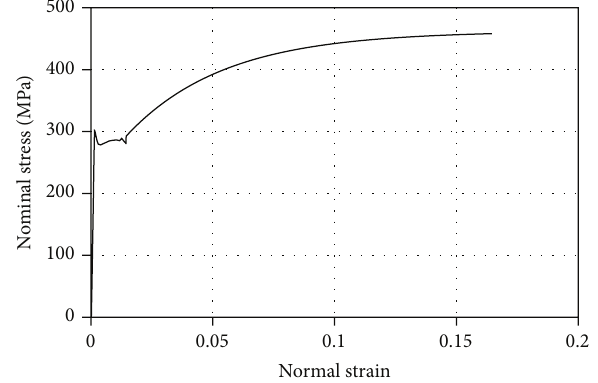
Figure 5: Nominal stress-strain of a test